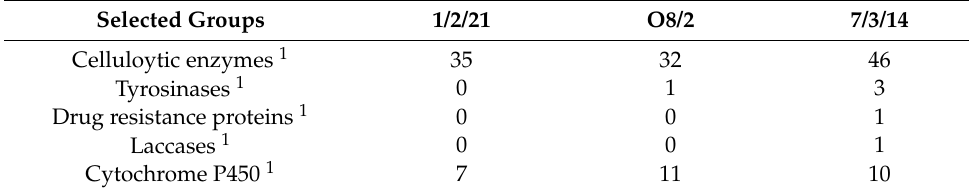
Table 1. Examples of predicted unique gene products for the different R. solani AG1-IB isolates. Selected Groups 1/2/21